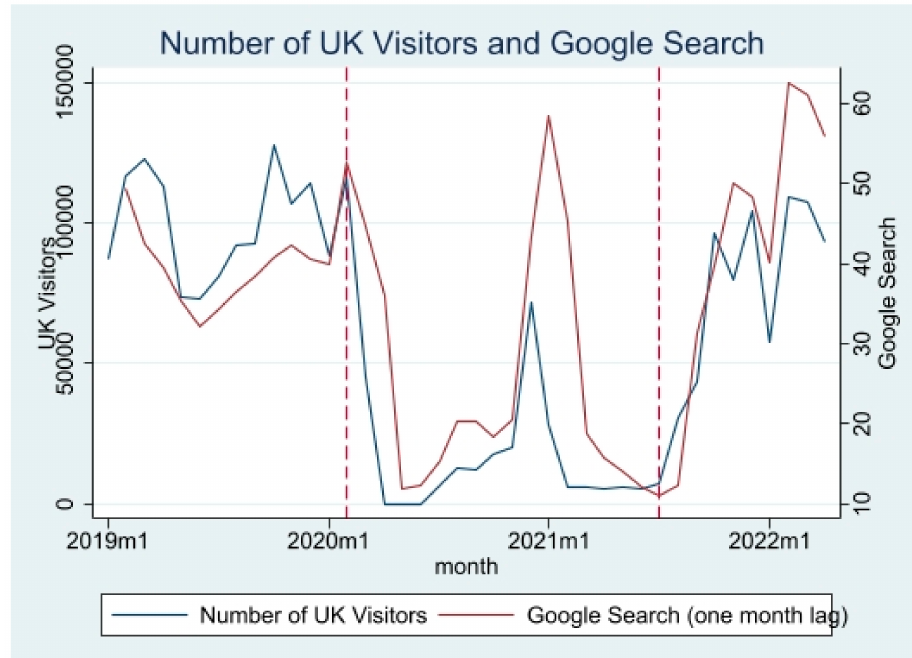
Figure 3. UK visitors and Google searches for accommodation and